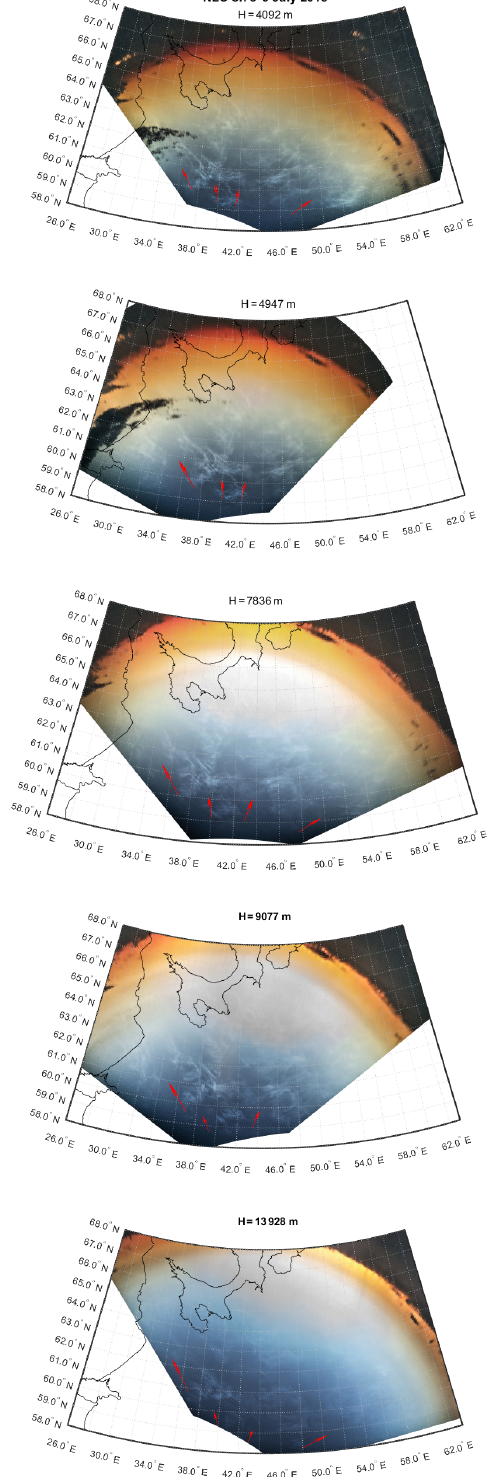
Figure 5. Projection of the NLC fields (shown in Fig. 4) as observed from the SONC balloon on the surface. The red arrows indicate the centres of large areas free from NLC particles (partial ice